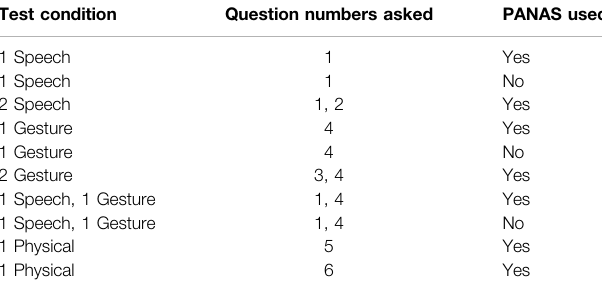
TABLE 3 | Question combinations for all test conditions within Phase